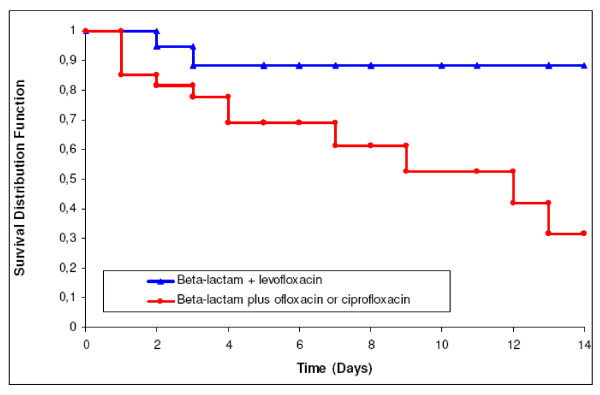
15-day survival curves in patients treated with β-lactam combined with levofloxacin versus β-lactam combined with ofloxacin or ciprofloxacin. Log rank test: p = 0.031